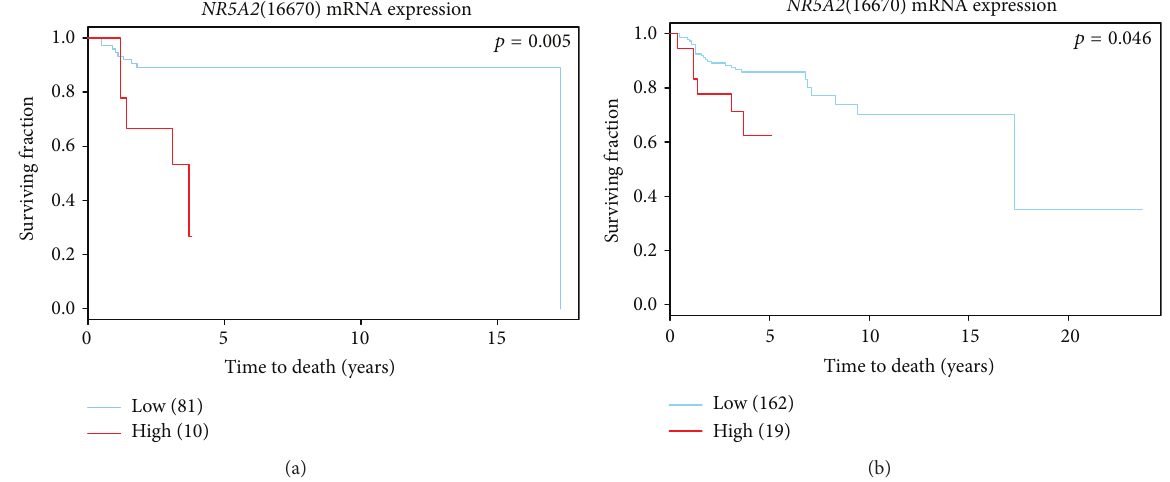
Figure 1: Kaplan-Meier survival analysis on NR5A2 in 91A and 181A cohorts. The survival curves of a breast tumor group with top 10% high NR5A2 mRNA levels versus the group with low NR5A2 mRNA levels in 91A cohort and 181A cohort,